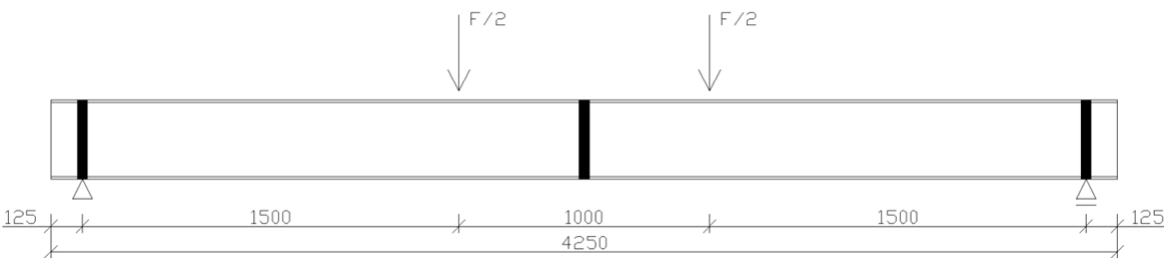
Fig. 9 Four-point bending test set-up of the of hybrid steel-glass beams with SikaFast-5211.